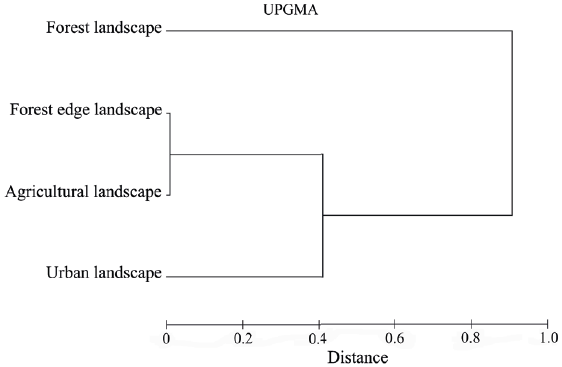
Figure 4 - Hierarchical cluster analysis (UPgMA, euclidean distance) resulting from the pairwise test of ANOSIM comparing the four landscapes types: agricultural landscape, forest landscape, forest edge landscape and urban